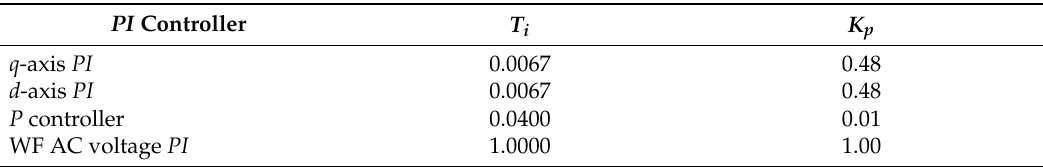
Table 6. PI controller